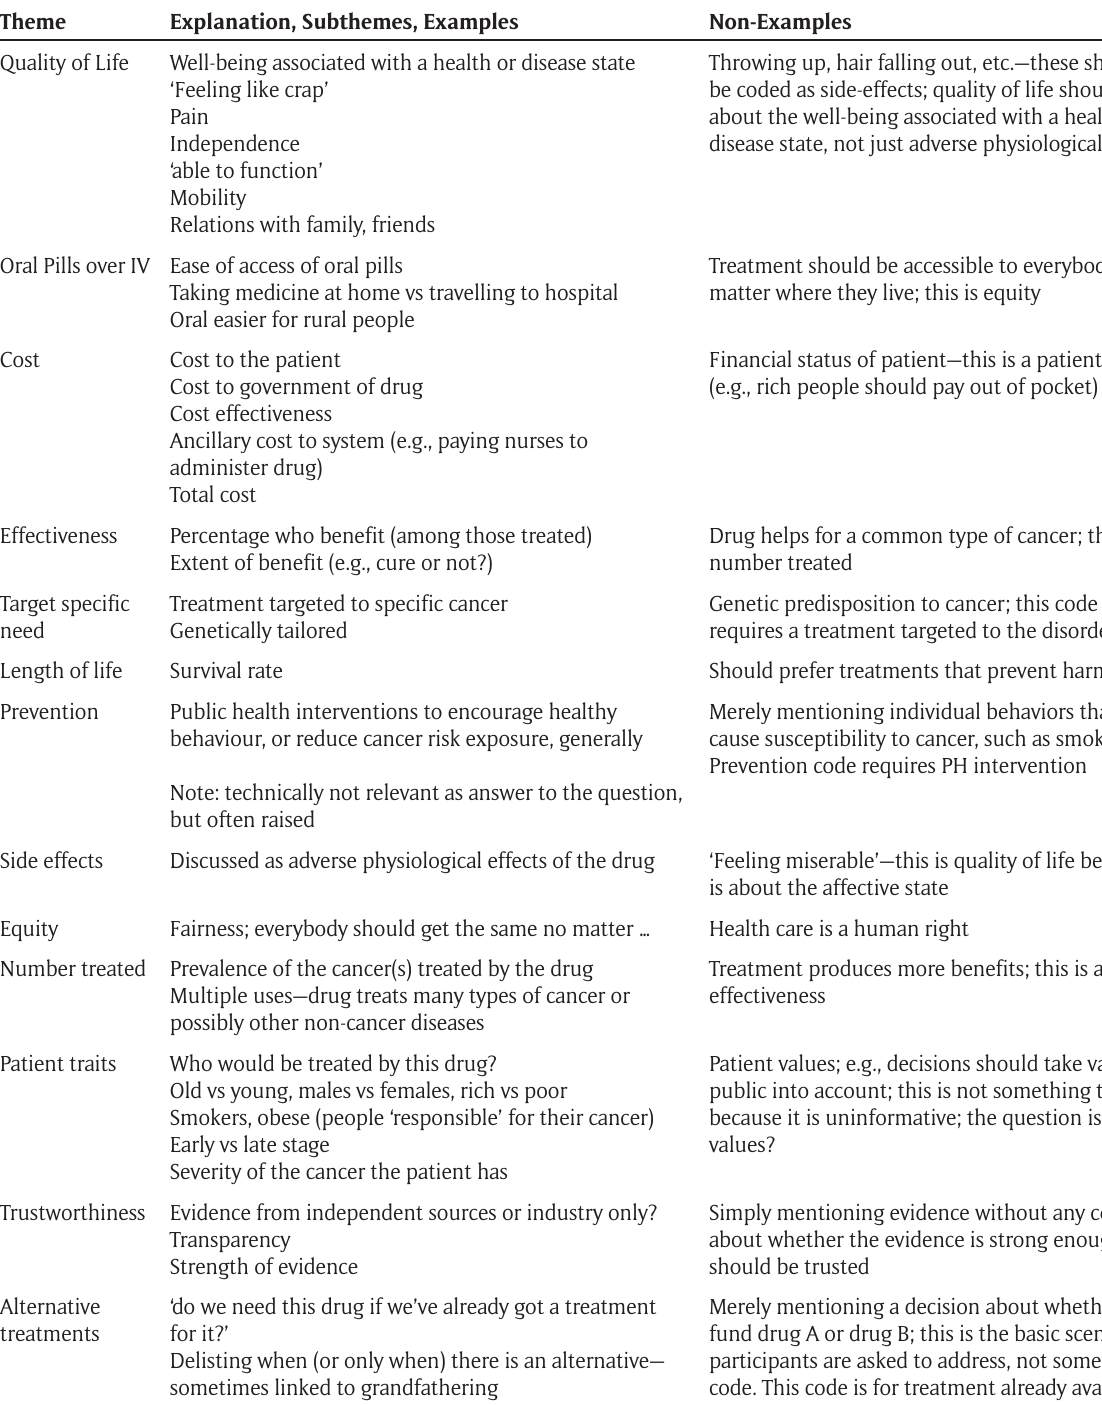
Table 1: Codebook for Day 1 of the CPAC Transcripts. Theme Explanation, Subthemes,